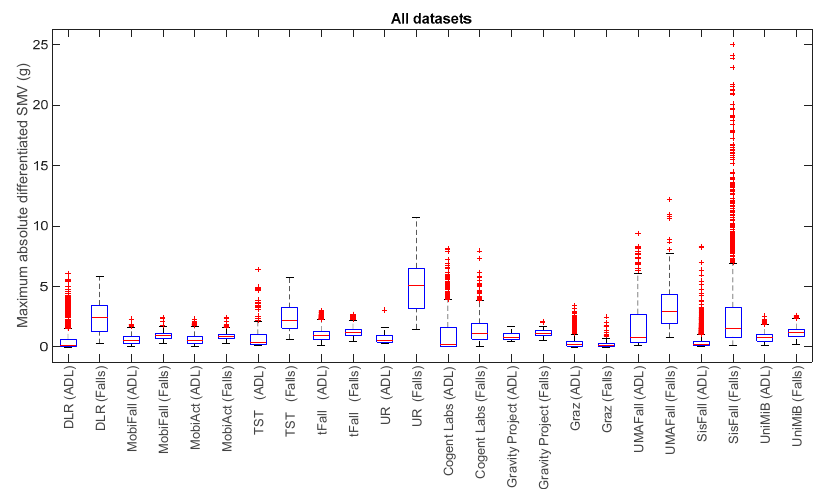
Figure 3. Boxplots of the maximum absolute value of the differentiated acceleration module for the falls and ADLs of all the datasets (for all the datasets only the acceleration signal at the waist—if not available—at the thigh is considered).